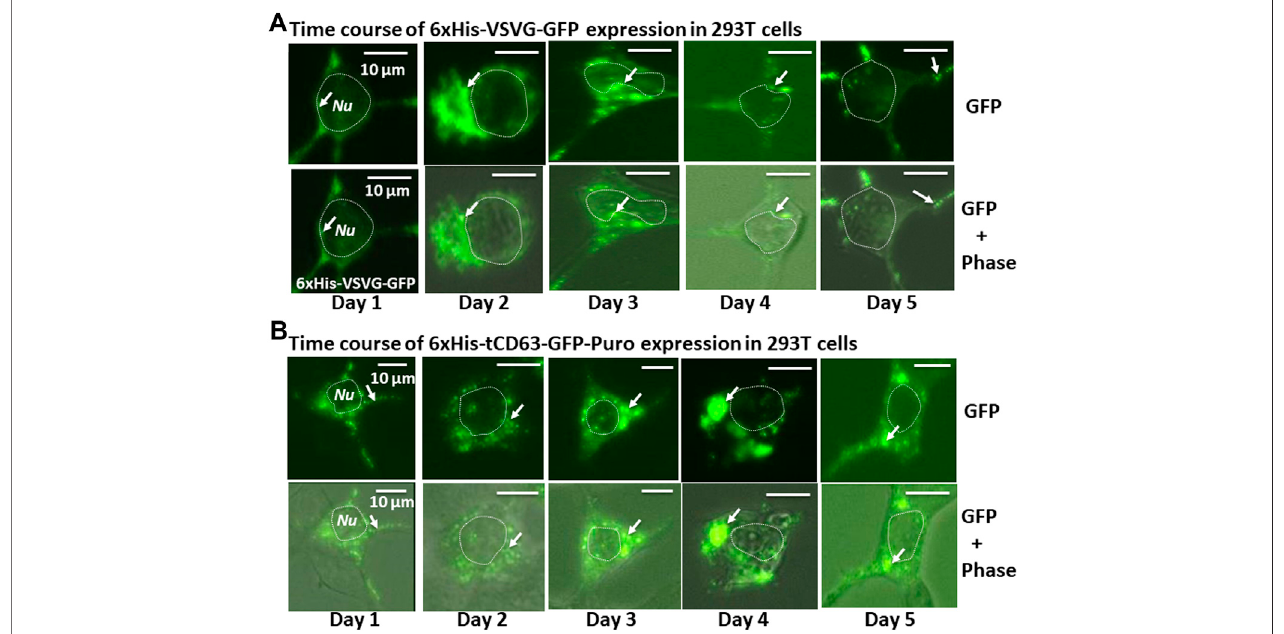
FIGURE 2 | Time-course study of stable labelling and imaging of EVs in living human 293T cells. 293T cells were transiently transfected with either 6xHis-VSVG- GFP. (A) or 6xHis-tCD63-GFP-Puro. (B) , and imaged after 24 h, and every subsequent day for fi ve consecutive days. The fl uorescence signals from these chimeric proteinswererecordedtodemonstrateexpressionlevelsandsubcellulardistribution.Upperpanelsare fl uorescentimages,whilethelowerpanelsareoverlaidimagesof green fl uorescent images and phase contrast images. Arrows indicate endosome/exosome/MVB structures. Dotted circles indicate cell nuclei ( Nu ). Scale bar, 10